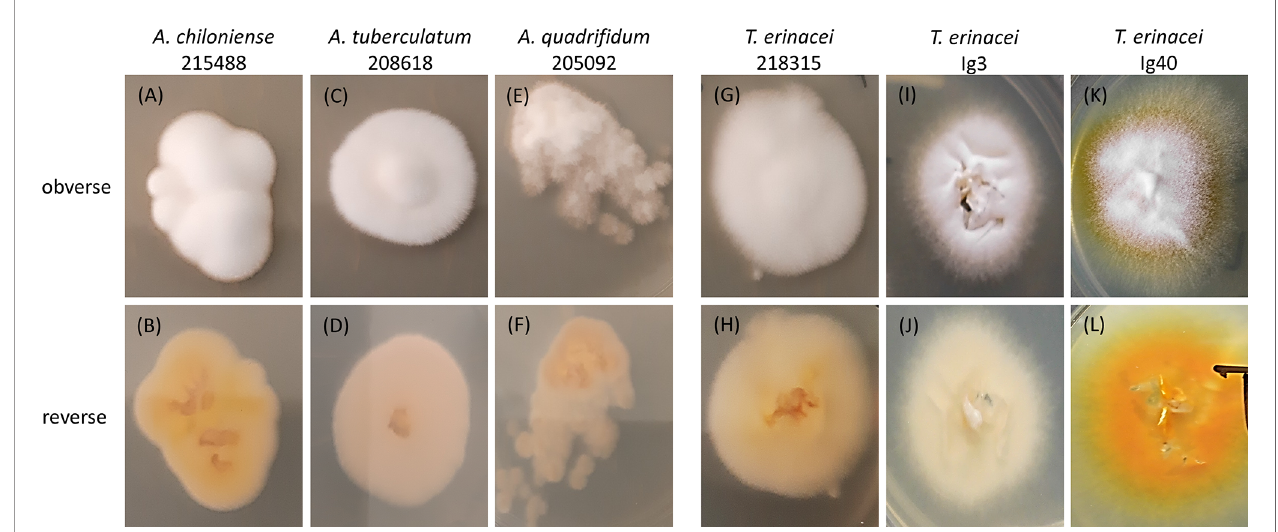
FIGURE 1 | Photographs of the colony morphology of selected Arthroderma (A.) spp. (A – F) and Trichophyton (T.) erinacei cultures (G – L) isolated from symptomatic and asymptomatic hedgehogs. Cultures were grown on Sabouraud-Dextrose agar (2%) at 28°C for 3d, species identity was con fi rmed by sequencing of the ITS region of fungal rDNA. The fi rst column shows the typical morphology of A. chiloniense with a white, fl uffy obverse (A) and a beige to yellow reverse (B) . T. erinacei 218315 (G, H) showed a very similar appearance rendering those two isolates hardly distinguishable solely by the assessment of phenotypic traits. The typical colony morphology of T. erinacei is depicted in (K) (obverse: white to yellow, granular) and (L) (reverse: yellow to bright orange). Intermediate, rather untypical morphologies ( fl uffy, folded, elevated in the center) with varying color shades from white to cream to beige are seen with other Arthroderma spp. and T. erinacei